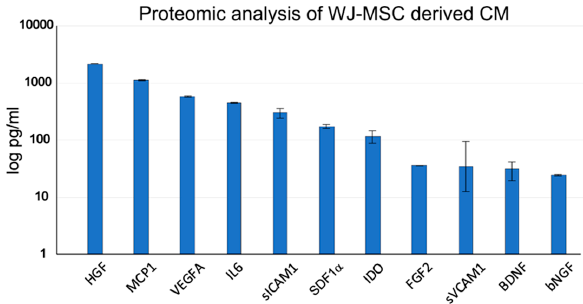
Figure 2. Proteomic analysis of the CM derived from WJ-MSCs.